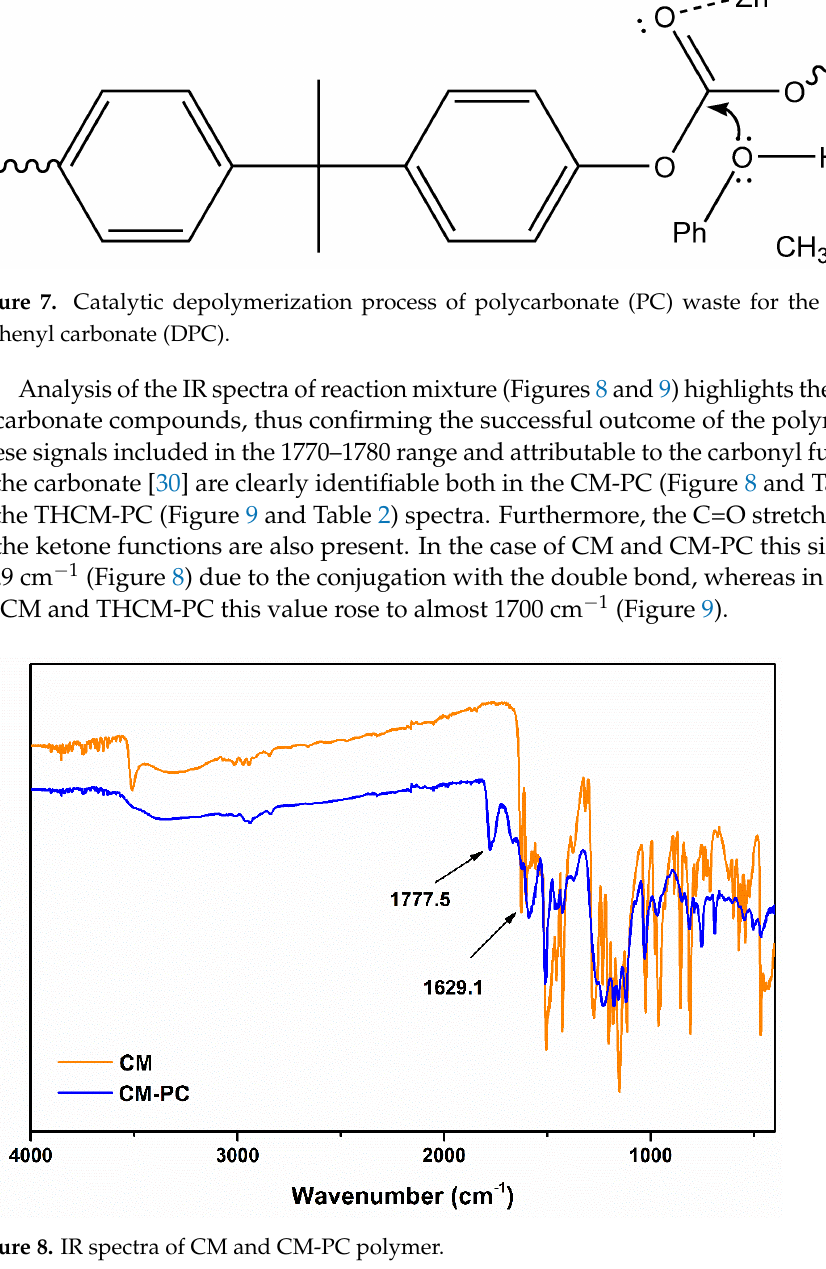
Figure 8. IR spectra of CM and CM-PC polymer.